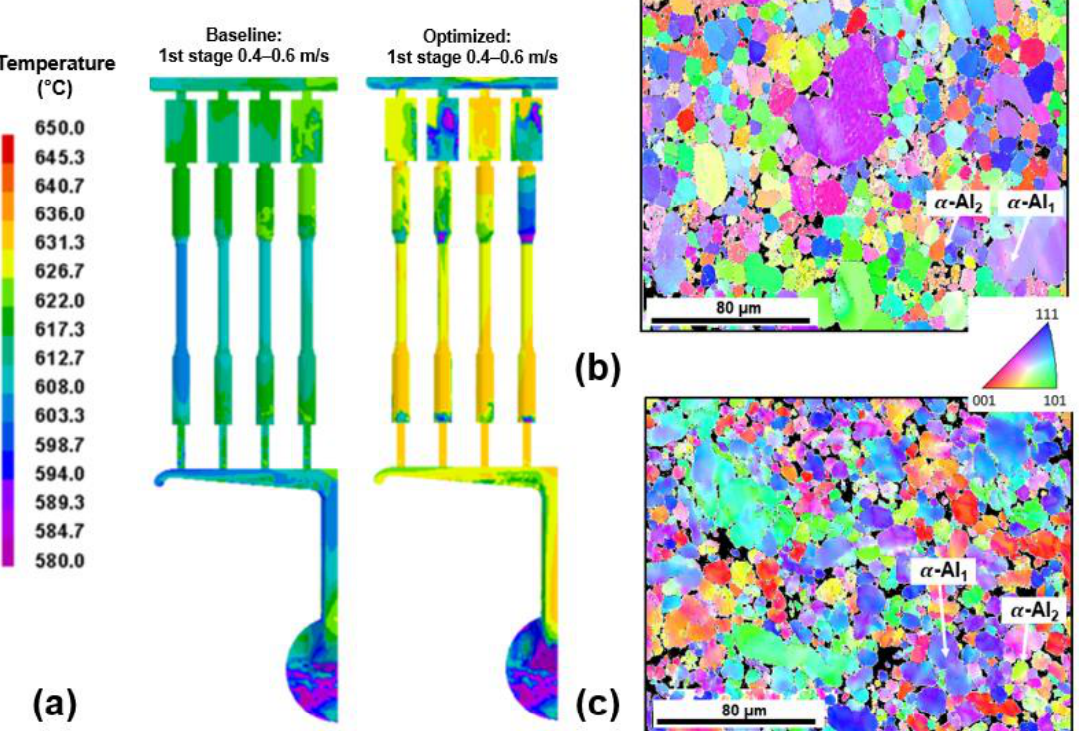
Figure 3. ( a ) ProCAST simulations depicting melt temperature at the end of die filling for Baseline and Optimised conditions [21]. Shown in ( b , c ) are EBSD IPF maps taken from the centre of the gauge length of tensile specimens produced under Baseline and Optimised conditions, respectively, show- ing primary 𝛼 -Al grains nucleated in the shot sleeve ( 𝛼 -Al